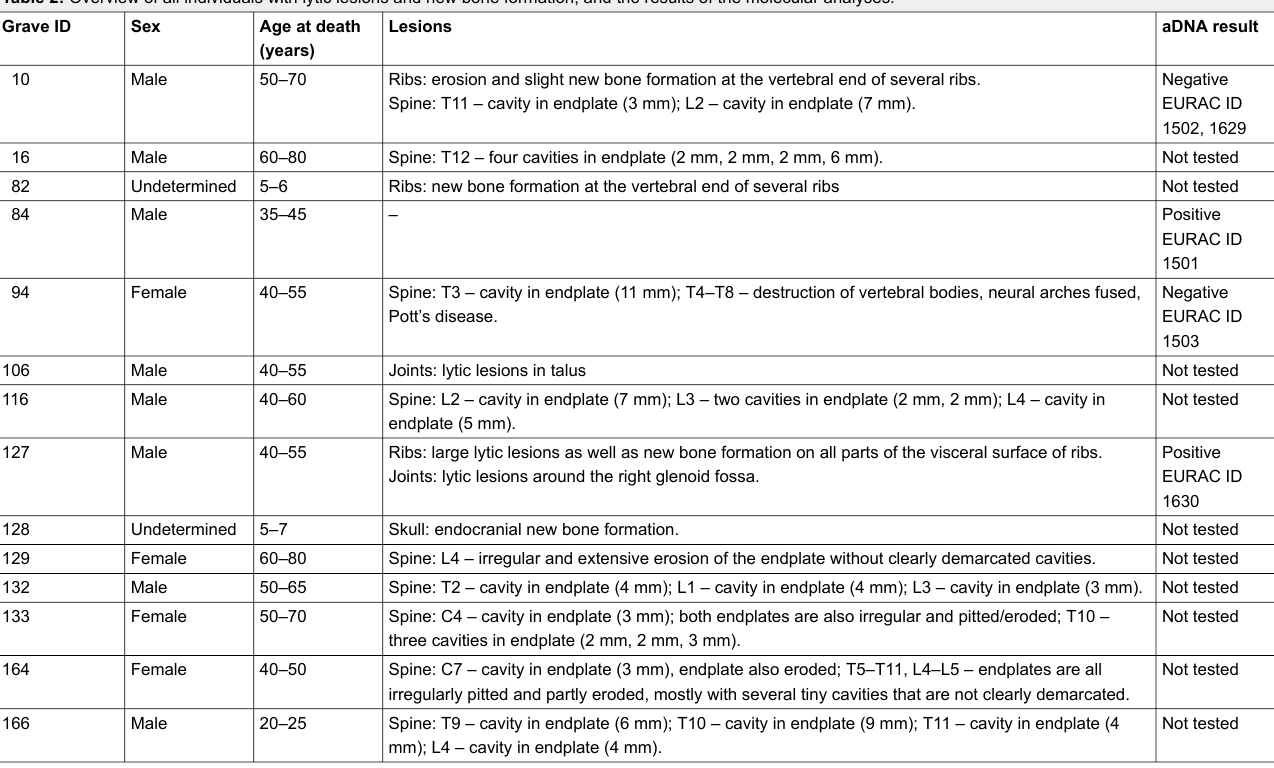
Table 2: Overview of all individuals with lytic lesions and new bone formation, and the results of the molecular